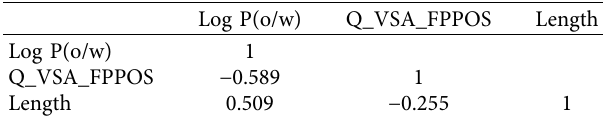
Table 6: Correlation matrix of descriptors.